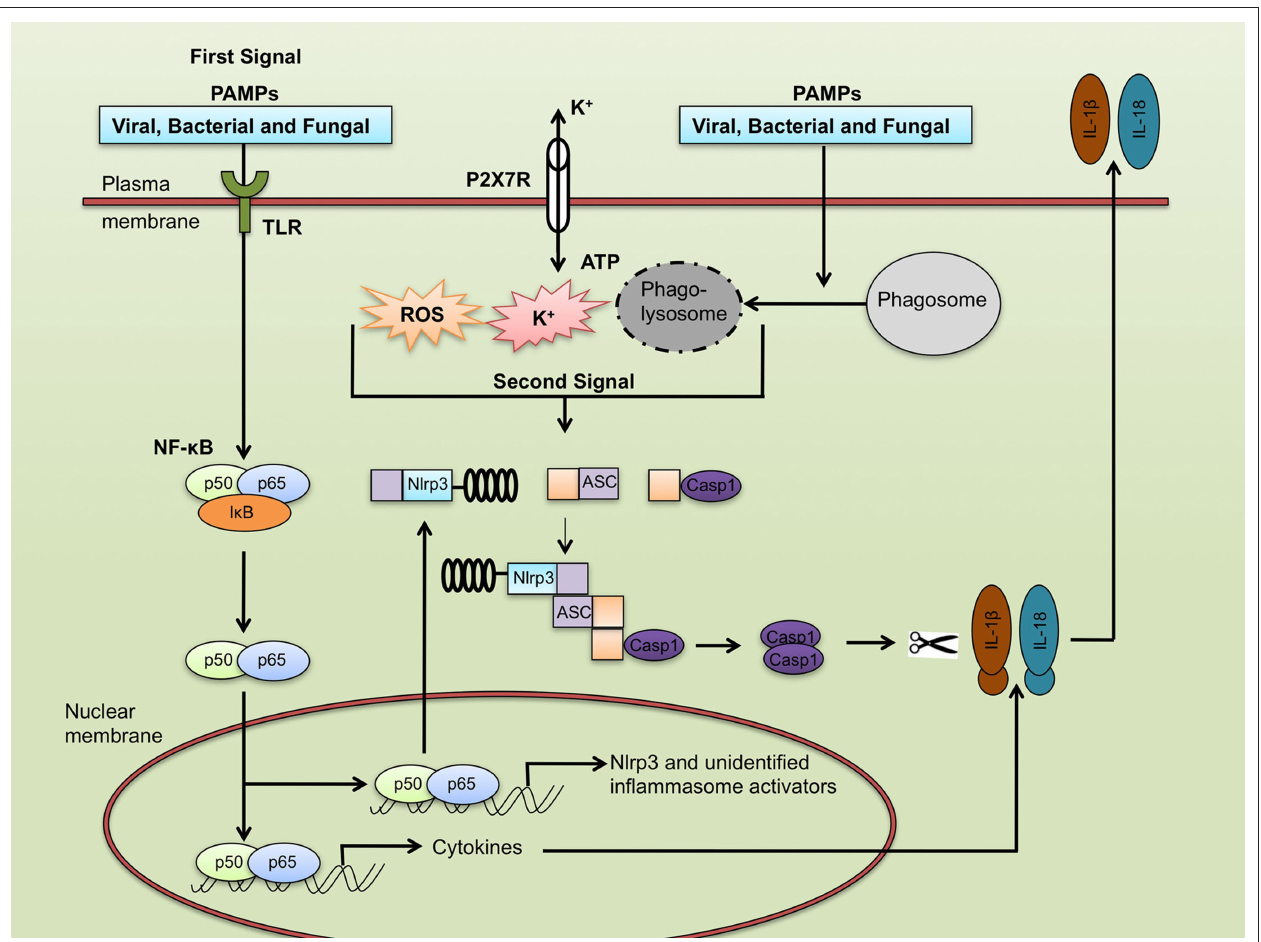
oxygen species (ROS) production (second signal). Activation of P2X7R by ATP results in membrane pores that allow K + efflux and entry of extracellular factors into the cytoplasm resulting in Nlrp3 activation. Phagocytosis of certain pathogenic microbes leads to rupture of lysosomes thereby releasing cathepsin B into the cytoplasm and causing Nlrp3 activation. Generation of ROS downstream of microbial infection has also been proposed to trigger Nlrp3. Nlrp3 inflammasome assembly consisting of the adaptor molecule Asc and pro-caspase-1 leads to caspase-1 activation, which results in processing and secretion of cytokines IL-1 β and